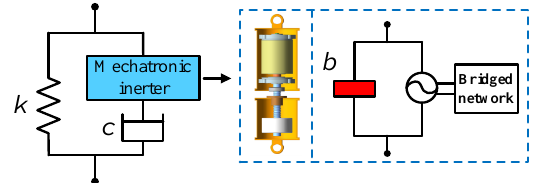
Figure 1. Seven-degree-of-freedom vehicle model.